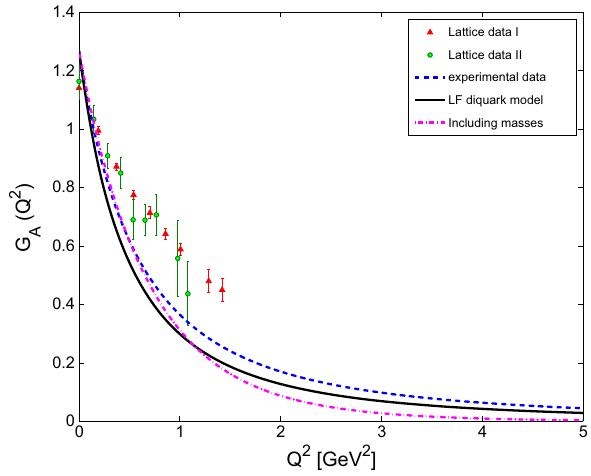
Fig. 4 (Color online) Plot of the axial-vector form factors G A ( Q 2 ) = ( Q 2 ) . The black solid line represents the quark–diquark model in G u − d A AdS/QCD, the blue dashed line represents dipole fit of experimental data [80] and the data are taken from lattice calculation [82]. The pink dashed-dot line represents the result by including quark and diquark masses in the wave functions (Eq.